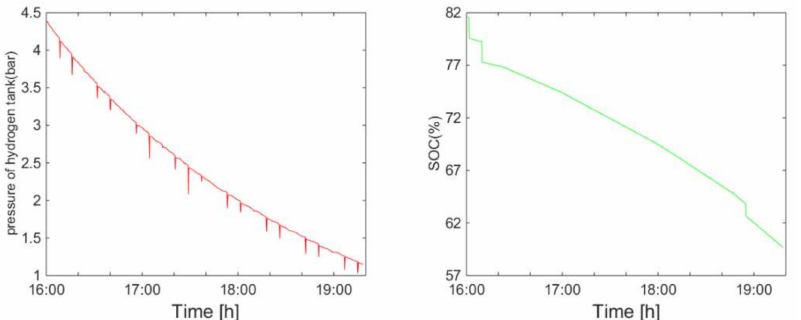
Figure 22. Operation state curves in scenario 7 (with the fuel cell).